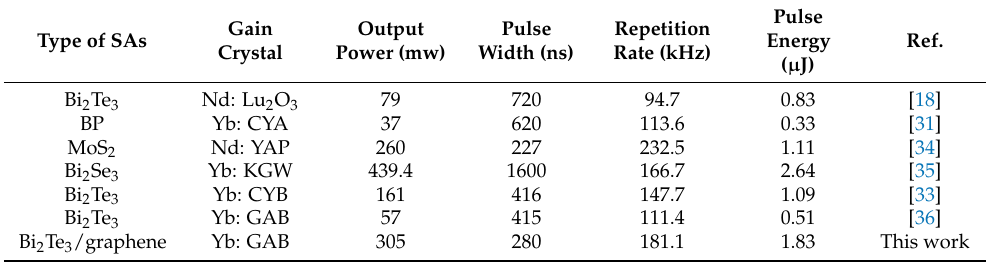
Table 2. Comparison of ∼ 1 µ m passively Q-Switched laser performance using 2D